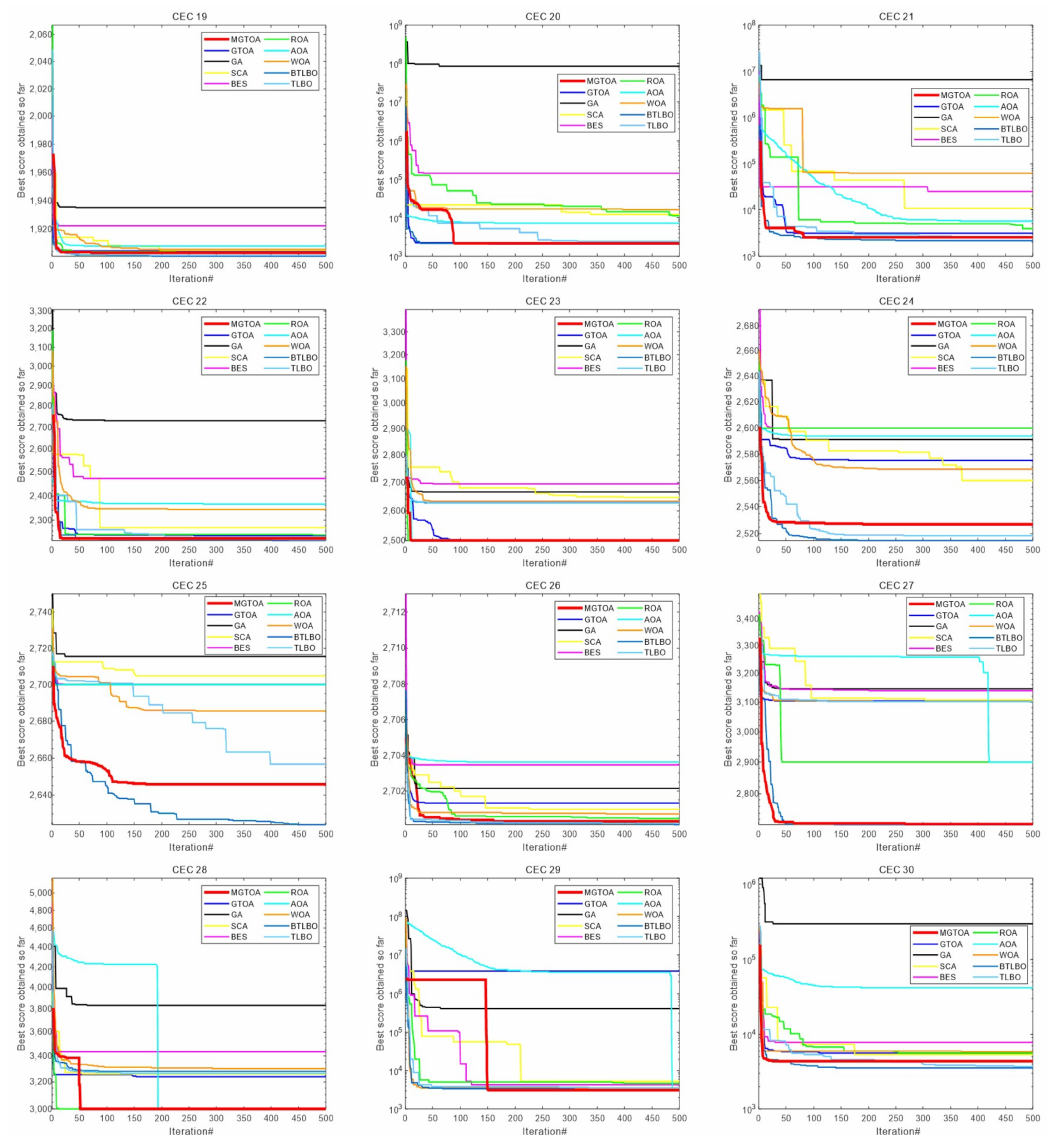
Figure 7. Convergence curves for the optimization algorithms for test functions on